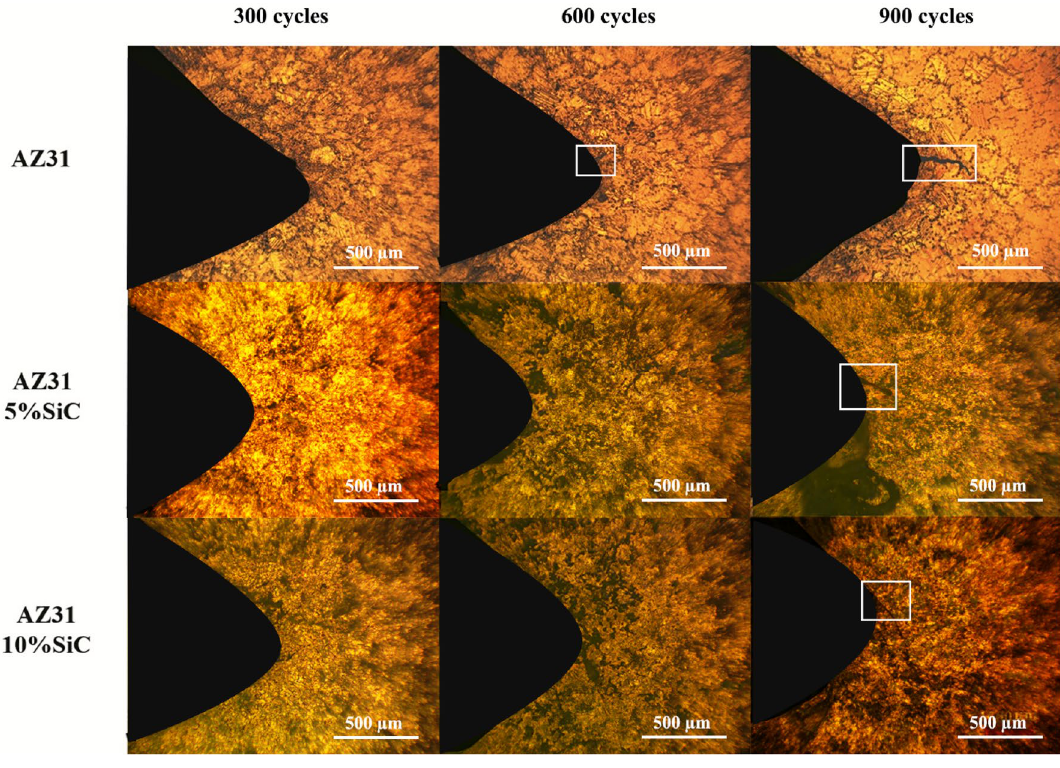
Figure 9. OM micrographs of as-cast unreinforced alloy and composites samples after 300, 600 and 900 thermal cycles at 150 °C.